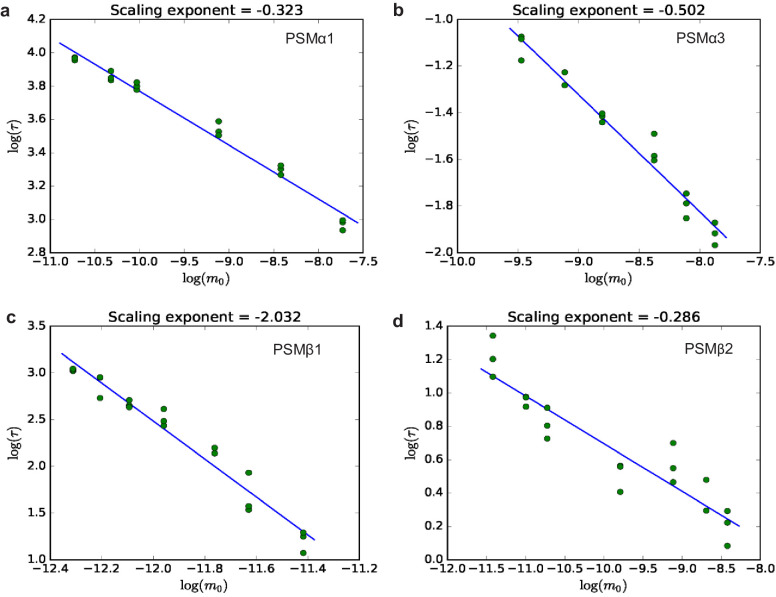
Half-time plots for phenol-soluble modulin (PSM)α1, PSMα3, PSMβ1, and PSMβ2.The half times of fibril formation as a function of initial monomer concentration on double logarithmic axes. The slope of the fitted line gives the scaling exponent (γ), obtained from three repeats of the aggregation experiments for each peptide. (a) PSMα1, (b) PSMα3, (c) PSMβ1, and (d) PSMβ2. The straight line in all four plots indicates that the dominant mechanism of fibril multiplication is the same for all monomer concentrations for the individual peptides studied here.
Figure 1—figure supplement 3—source data 1.Source data for half-time plots.